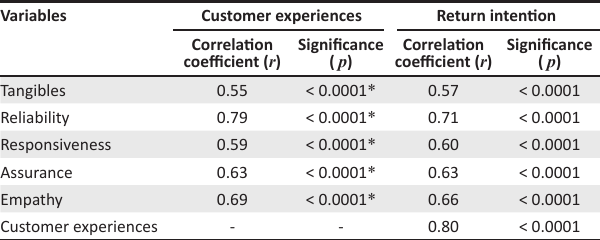
TABLE 3: Correlation results of customer experiences and return intention. Variables Customer experiences